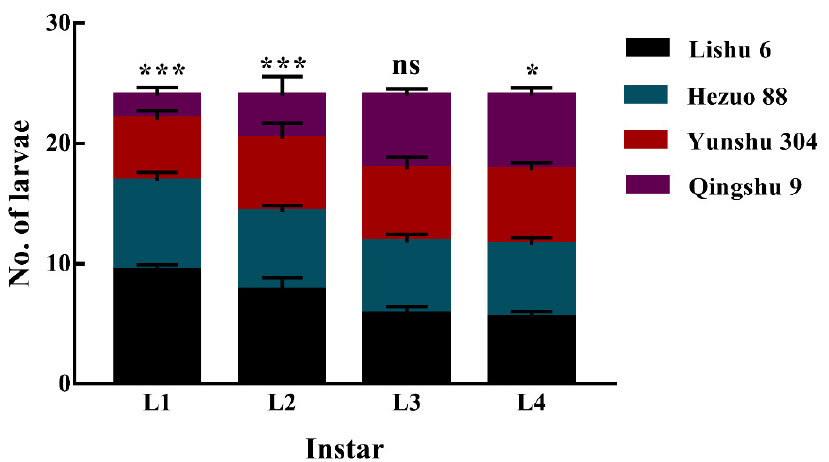
Figure 5. Number of P. operculella larvae fed on four different potato tuber varieties. Different lowercase letters indicate means are significantly different at ns, * p < 0.05; *** p < 0.001.